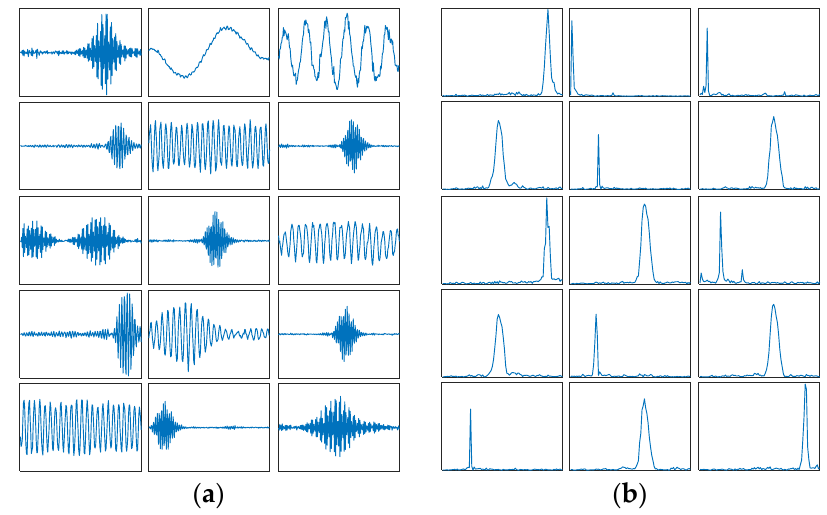
Figure 15. Row vectors of W : ( a ) Vectors of N in = 200 in the time domain; ( b ) Vectors of N in = 200 in the frequency domain.